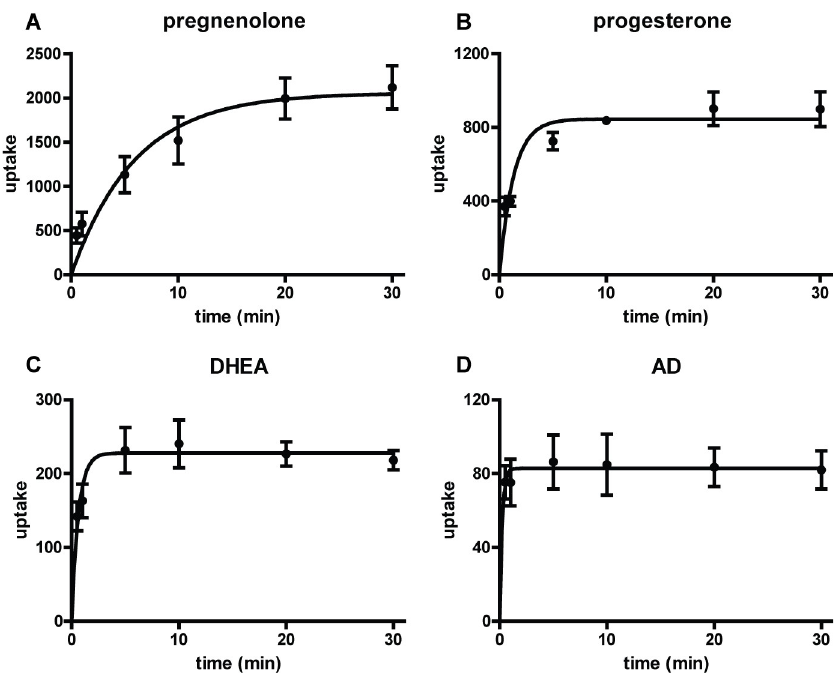
Fig 4. Half maximal free steroid uptake occurs within minutes with highest uptake favoring 3 β -OH, Δ 5 -steroids and progestogens. Concentrations (mean ± SD) of pregnenolone (A) , progesterone (B) , DHEA (C) , and AD (D) in prostate cancer (LNCaP) cell samples at time points ranging from 0 to 30 min. Uptake is expressed in units of μ L/mg (see Methods). One-phase association curves were fit to data using GraphPad Prism 5. Half-maximum times with 95% confidence intervals: pregnenolone 4.1 min (3.2–5.8 min), progesterone 0.91 min (0.75–1.18 min), DHEA 0.43 min (0.36–0.56 min), AD 0.16 min (0.10–0.35 min). The best-fit curve for each steroid was different from each other steroid’s best-fit curve (extra sum of squares F test, p < 0.001). All graphs represent three assays with duplicate samples; error bars represent standard